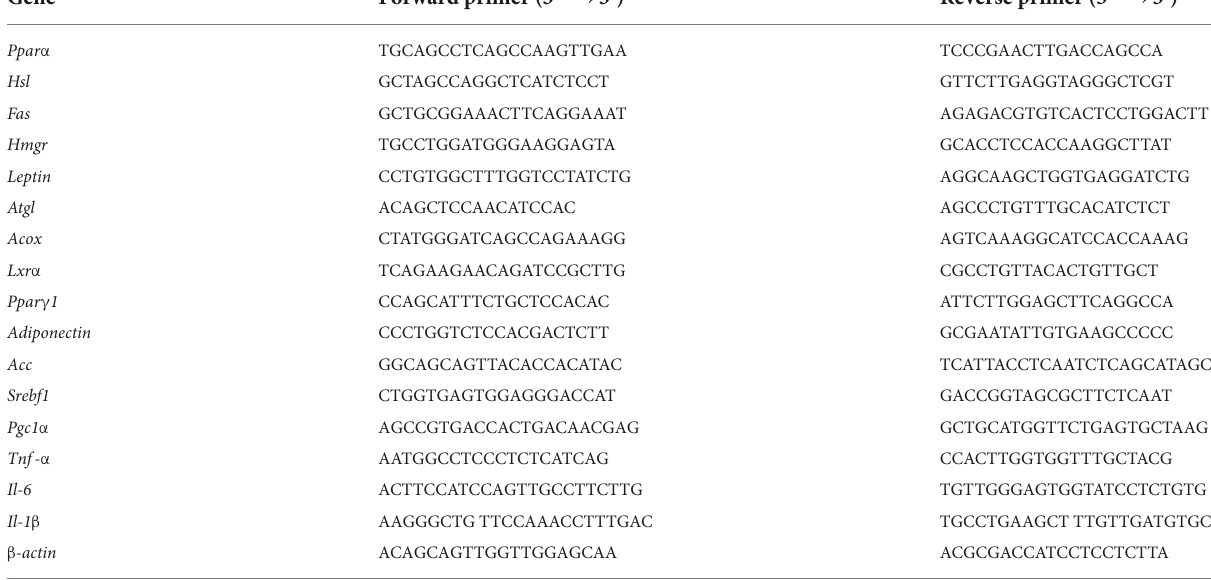
TABLE 1 Primer sequences for